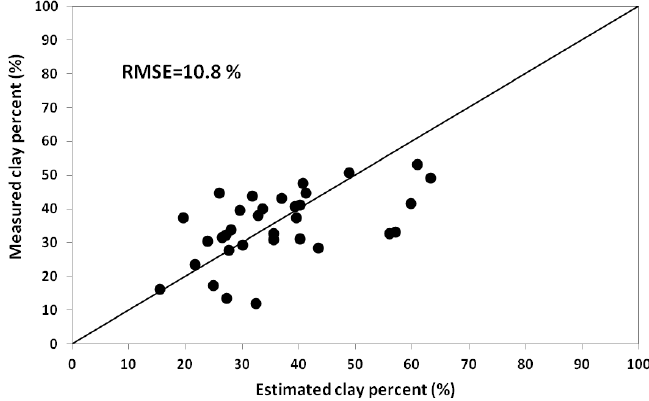
Figure 9. Comparison between estimated and ground truth measurements of clay content over 34 test